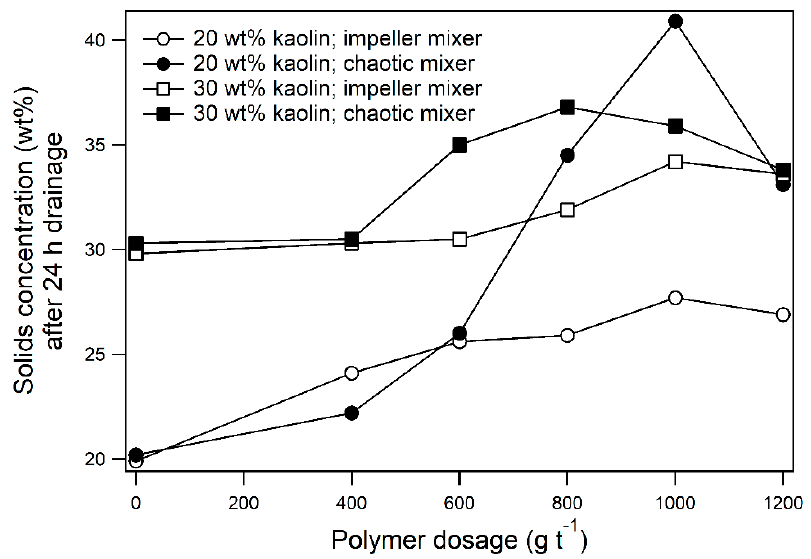
Figure 7. Effect of initial kaolin concentration, Magnafloc ® 336 dosage, and mixer type on the solids concentration after 24-h drainage.